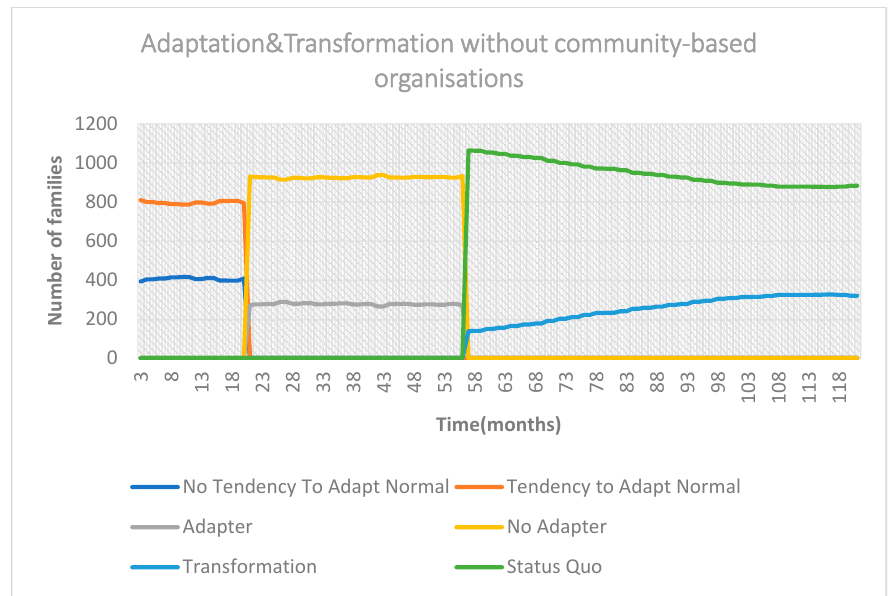
Figure 2. Adaptation and transformation outcomes for the community without CBOs.